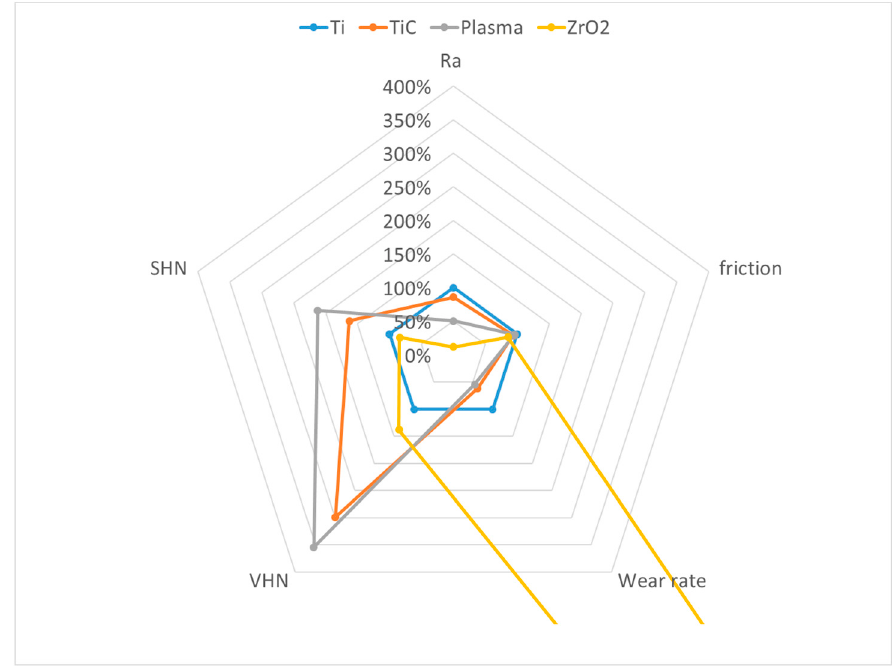
Figure 10. Comparison of the relevant mechanical properties of the plasma-processed samples compared with bare titanium and investigated state-of-the-art surface treatments.